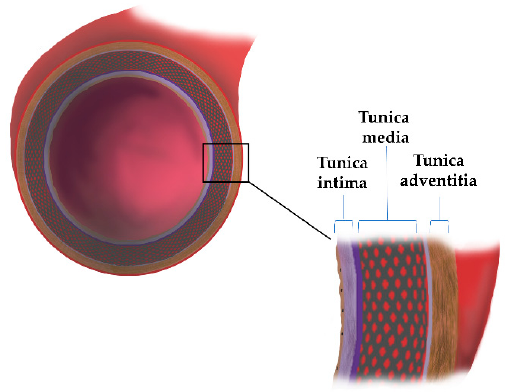
Figure 1. The schematic structure of the aorta wall. Table 1. The aortic wall structure: tunica intima (inner layer), tunica media (medium layer), tunica adventitia (external layer).